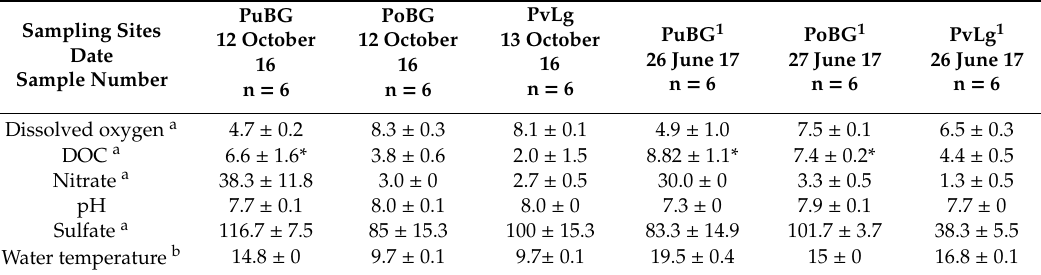
Table 1. Physicochemical parameters of water samples were obtained at three sampling sites (PuBG, PoBG, and PvLg) during two seasons (autumn 2016 and summer 2017). Shown are means of six replicates ± standard deviation. p- values were adjusted with one-way analysis of variance (ANOVA) (passed Shapiro–Wilk test) and Holm–Sidak test. *Significant di ff erence ( p < 0.05) in comparison with PvLg site. Significance was tested for both seasons separately. All samples were measured in surface water; exclude DOC values were measured in pore